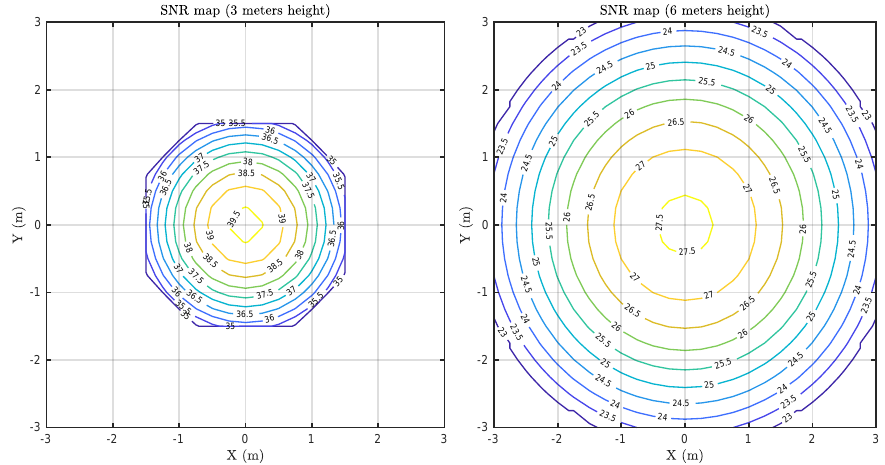
Figure 13. Signal-to-noise ratio (SNR) map at a 3 m height ( left ). SNR map at a 6 m height ( right ). In both cases, the receiver has been considered to point